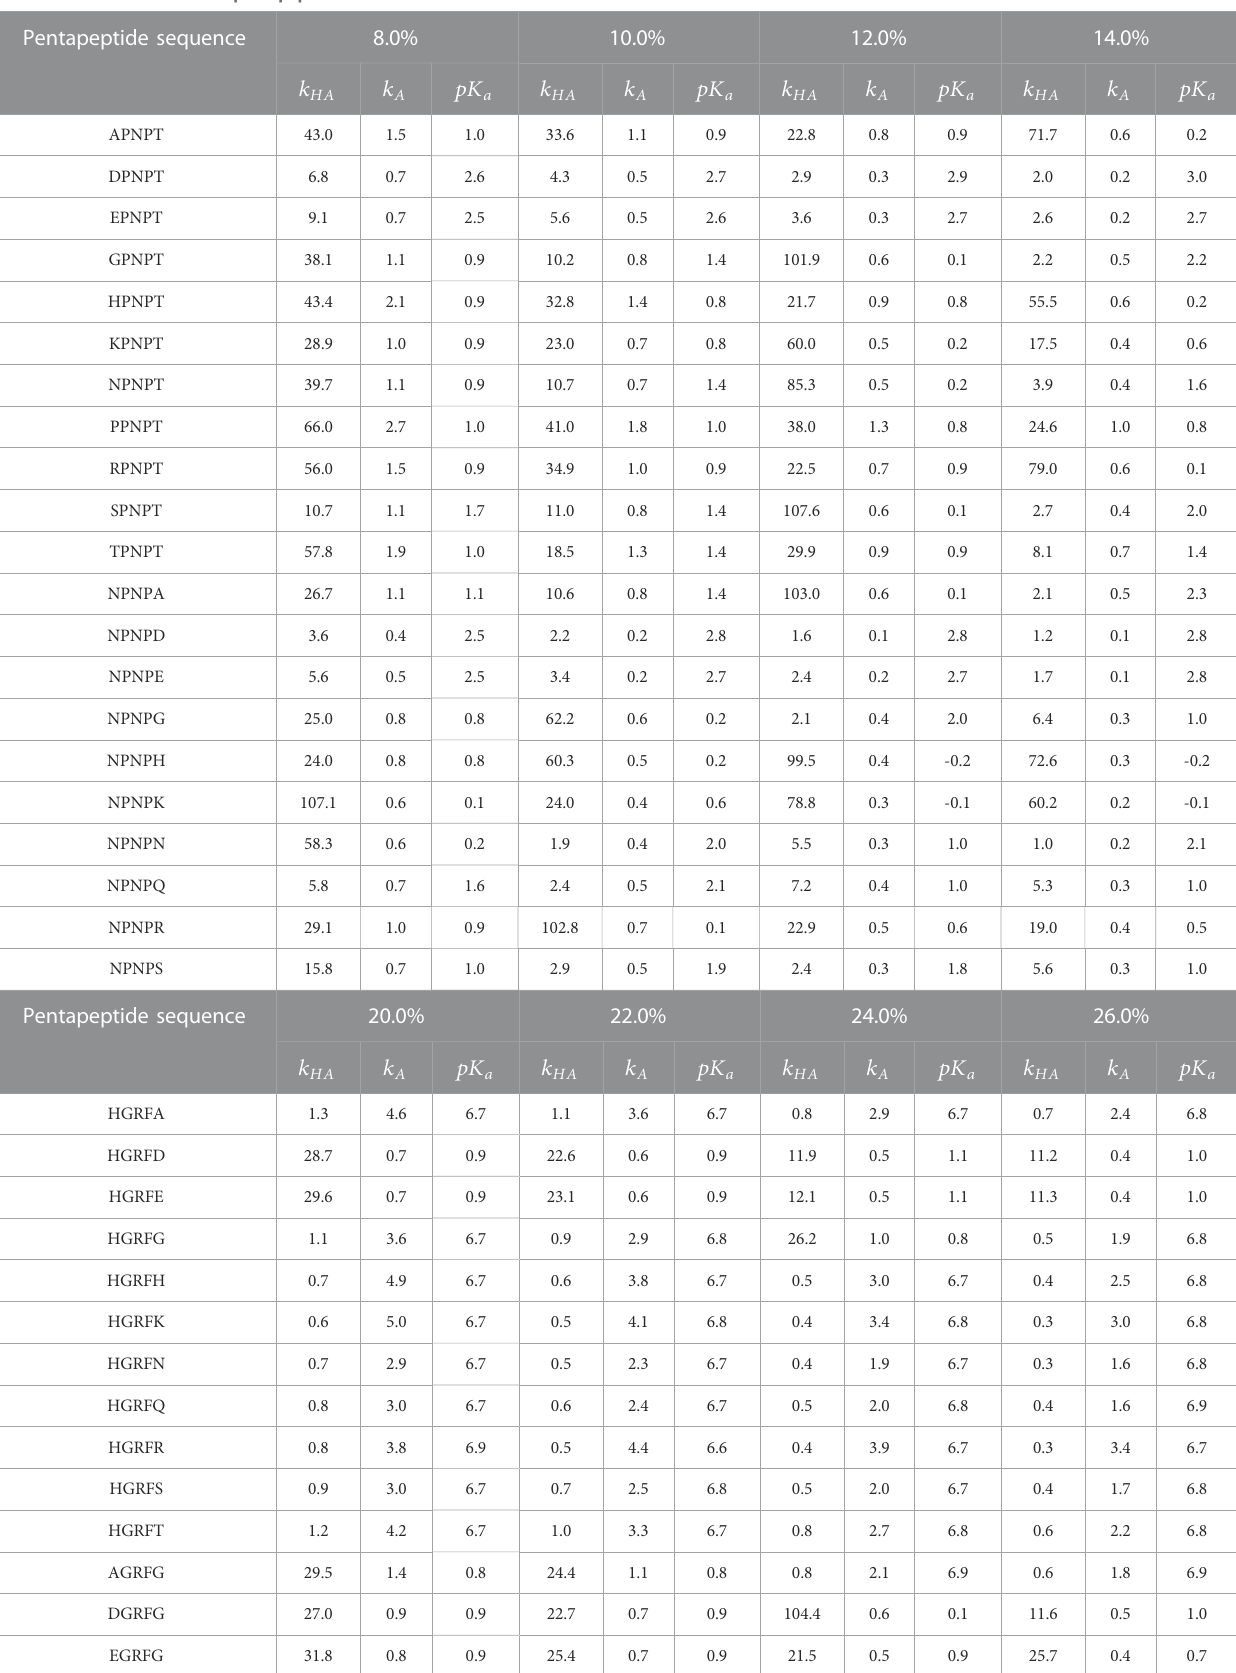
TABLE 4 Parameter results of pentapeptides at 45 ° C. Pentapeptide